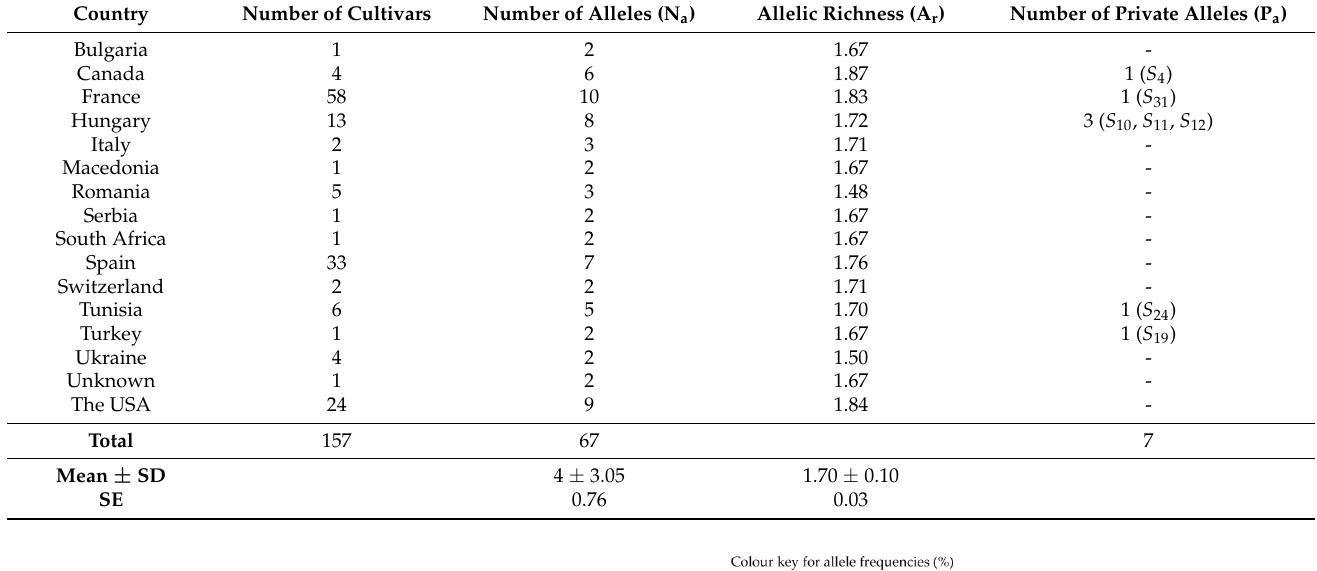
Table 4. Genetic parameters of apricot cultivars released from breeding programs. Number of cultivars, number of alleles (N a ), allelic richness (A r ), and number of private alleles (P a ) for each country of origin. SD: standard deviation; SE: standard error.